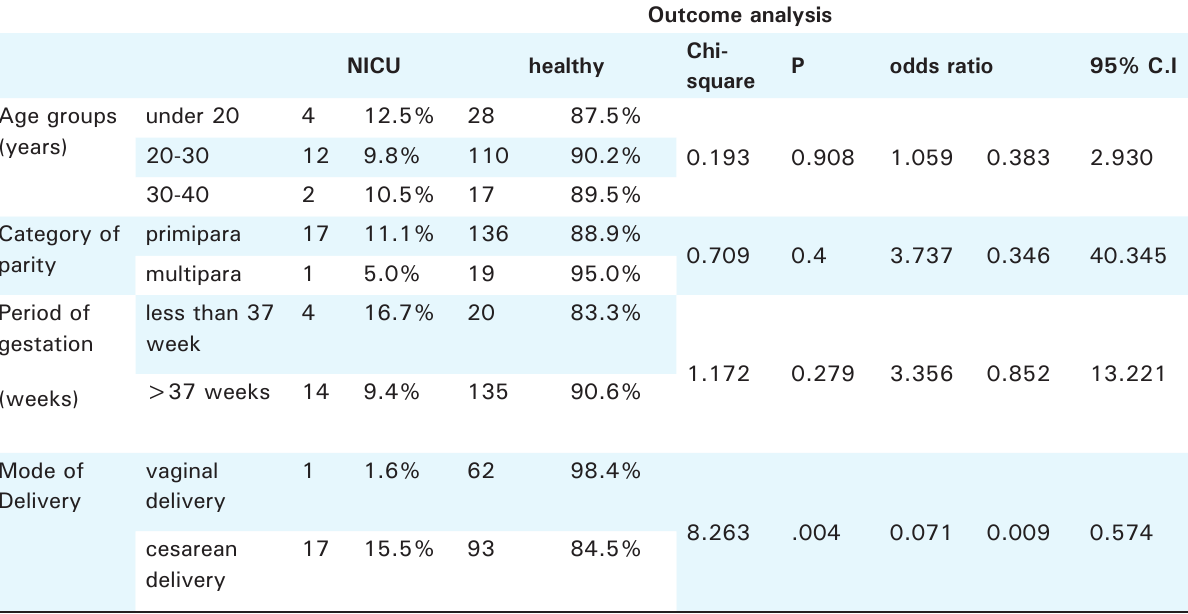
Table 2. Binary logistic regression analysis of comparison of outcome among vaginal breech and cesarean breech